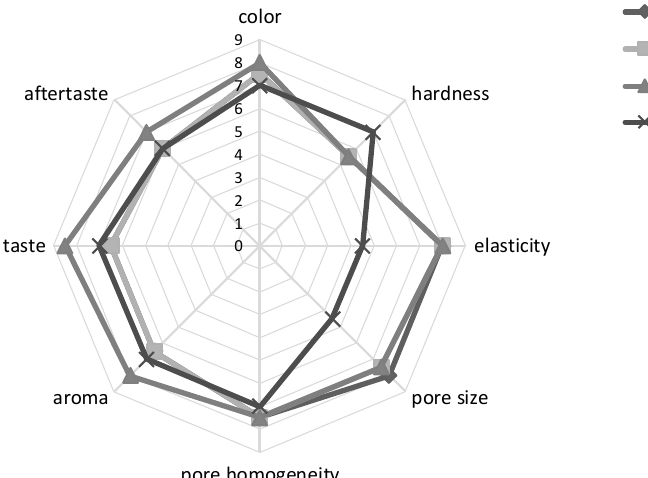
Figure 5. Spider web chart of the sensory analysis for puccia breads made in the bakery with liquid sourdough, without salt (B0 C2.27 ) or with 1.5% salt (B1.5 C2.27 ), and puccia breads made with baker’s yeast, without salt (B0 CTR ) or with 1.5% salt (B1.5 CTR ).